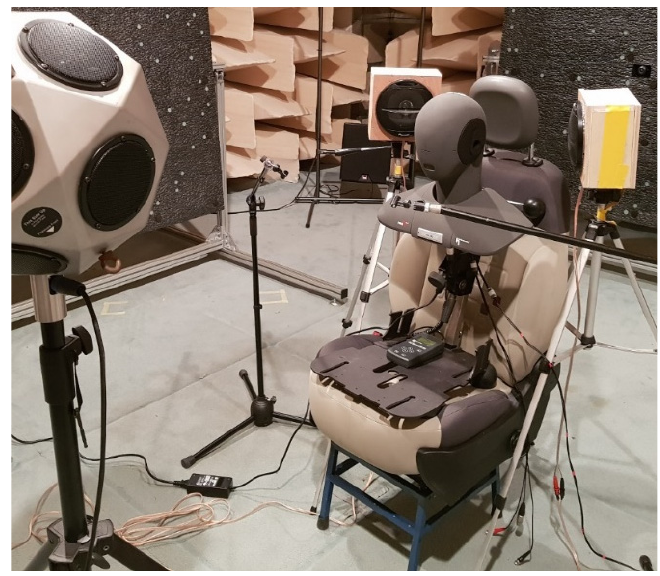
Figure 4. ANC tests under semi ‐ anechoic conditions. A schematic of the experimental set-up is shown in Figure 5. The dodecahedral source emitted the disturbing noise, whereas the counteracting acoustic field was generated by two (left and right) Pioneer TS-G1711I 17 cm dual-cone (170 Watt) loudspeakers. During all the tests, the microphone signals were conditioned by a PCB 16 channel ICP conditioner. Three types of acoustic sensors were used: two (left and right) 1 ” control microphones, 2 two embedded microphones in the binaural head, and one probe for sound intensity measurements. The first couple of microphones provided the error signals processed by the active control system. The second one was used to monitor the ANC performance in terms of sound pressure level reduction.